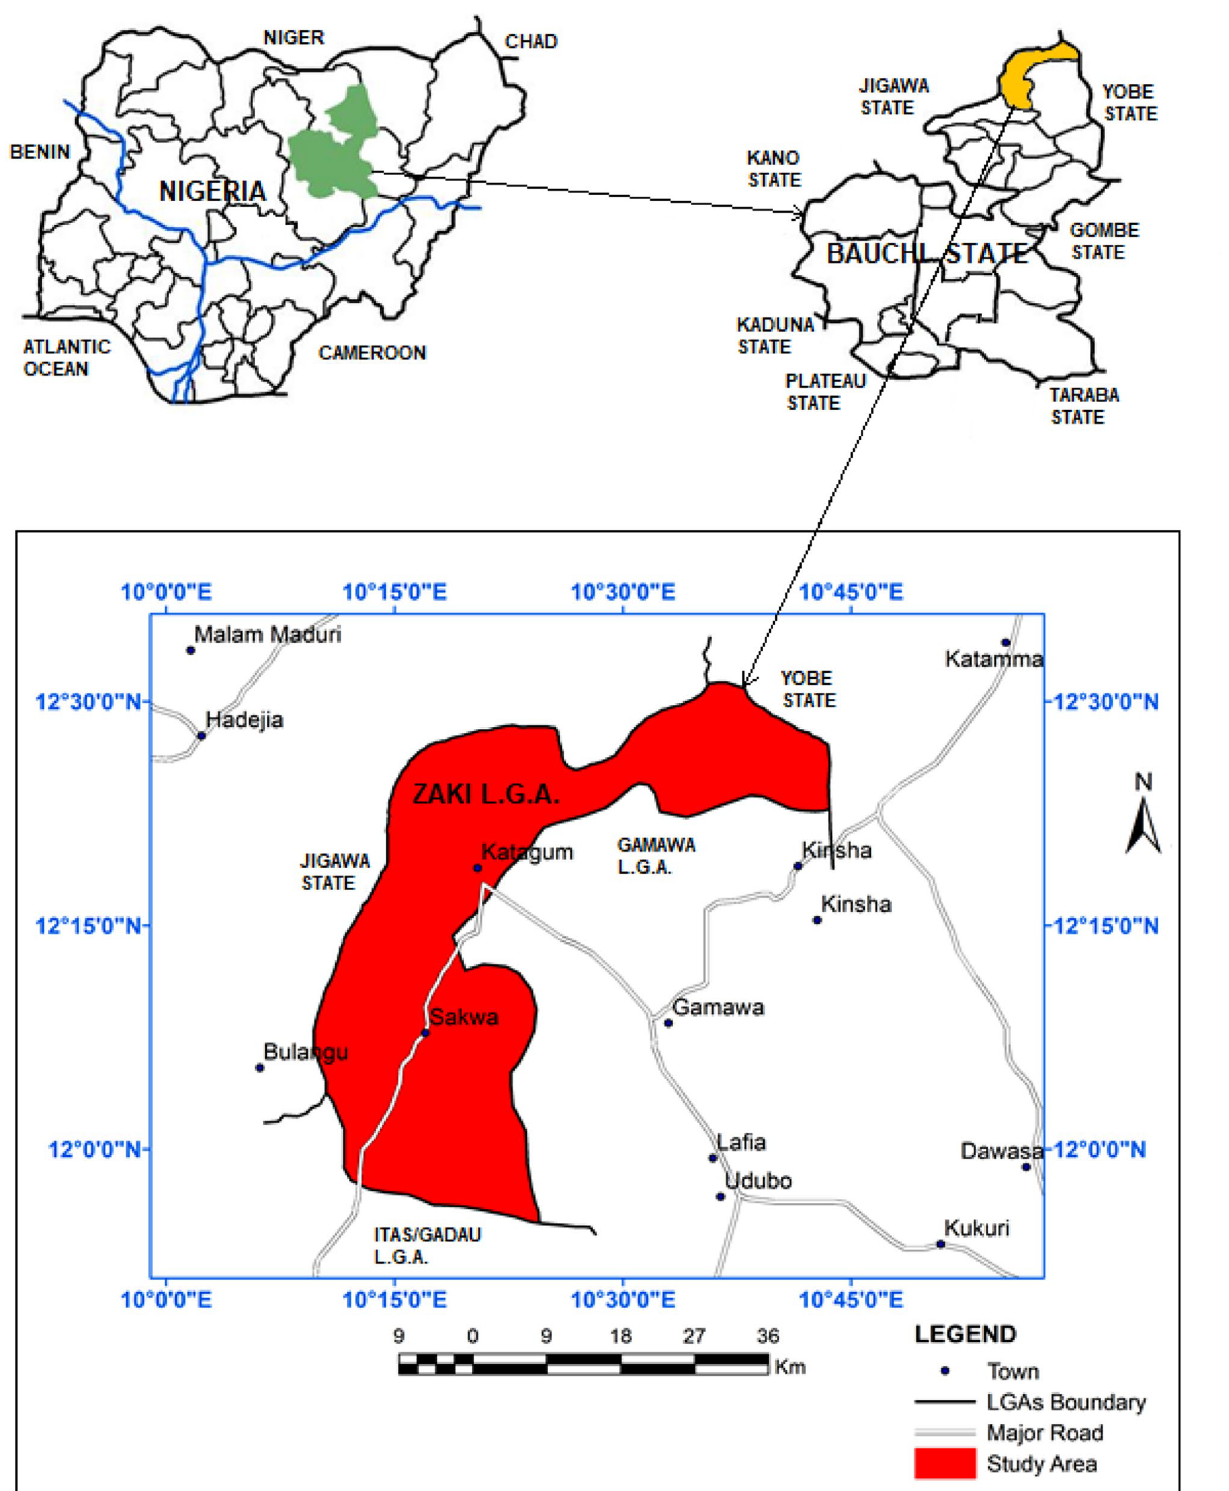
Fig. 1 The study